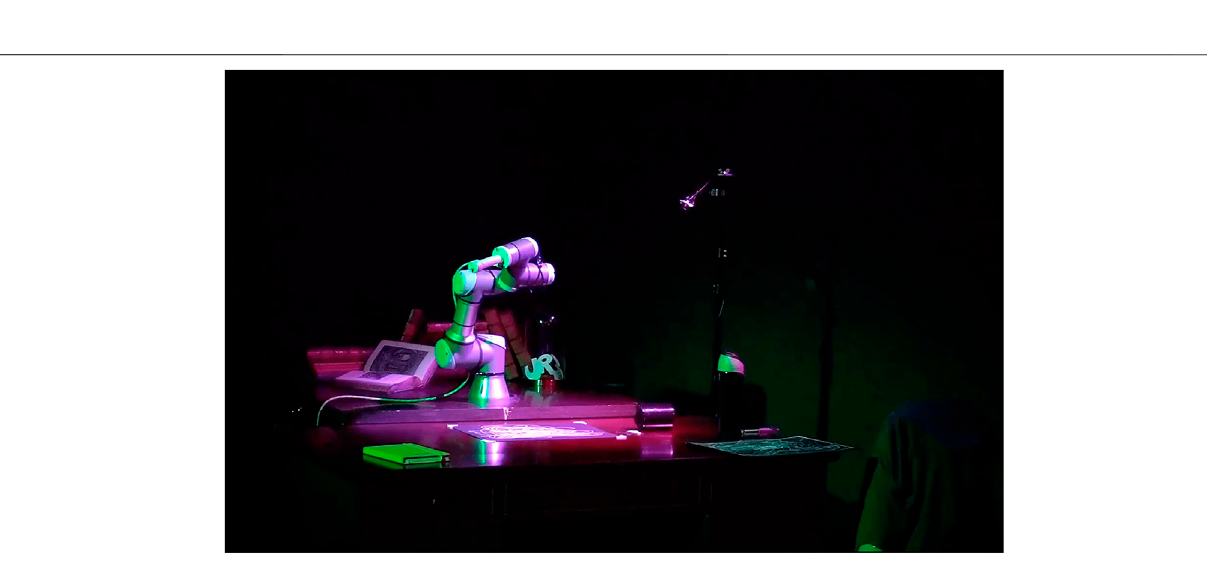
Frontiers in Robotics and AI |